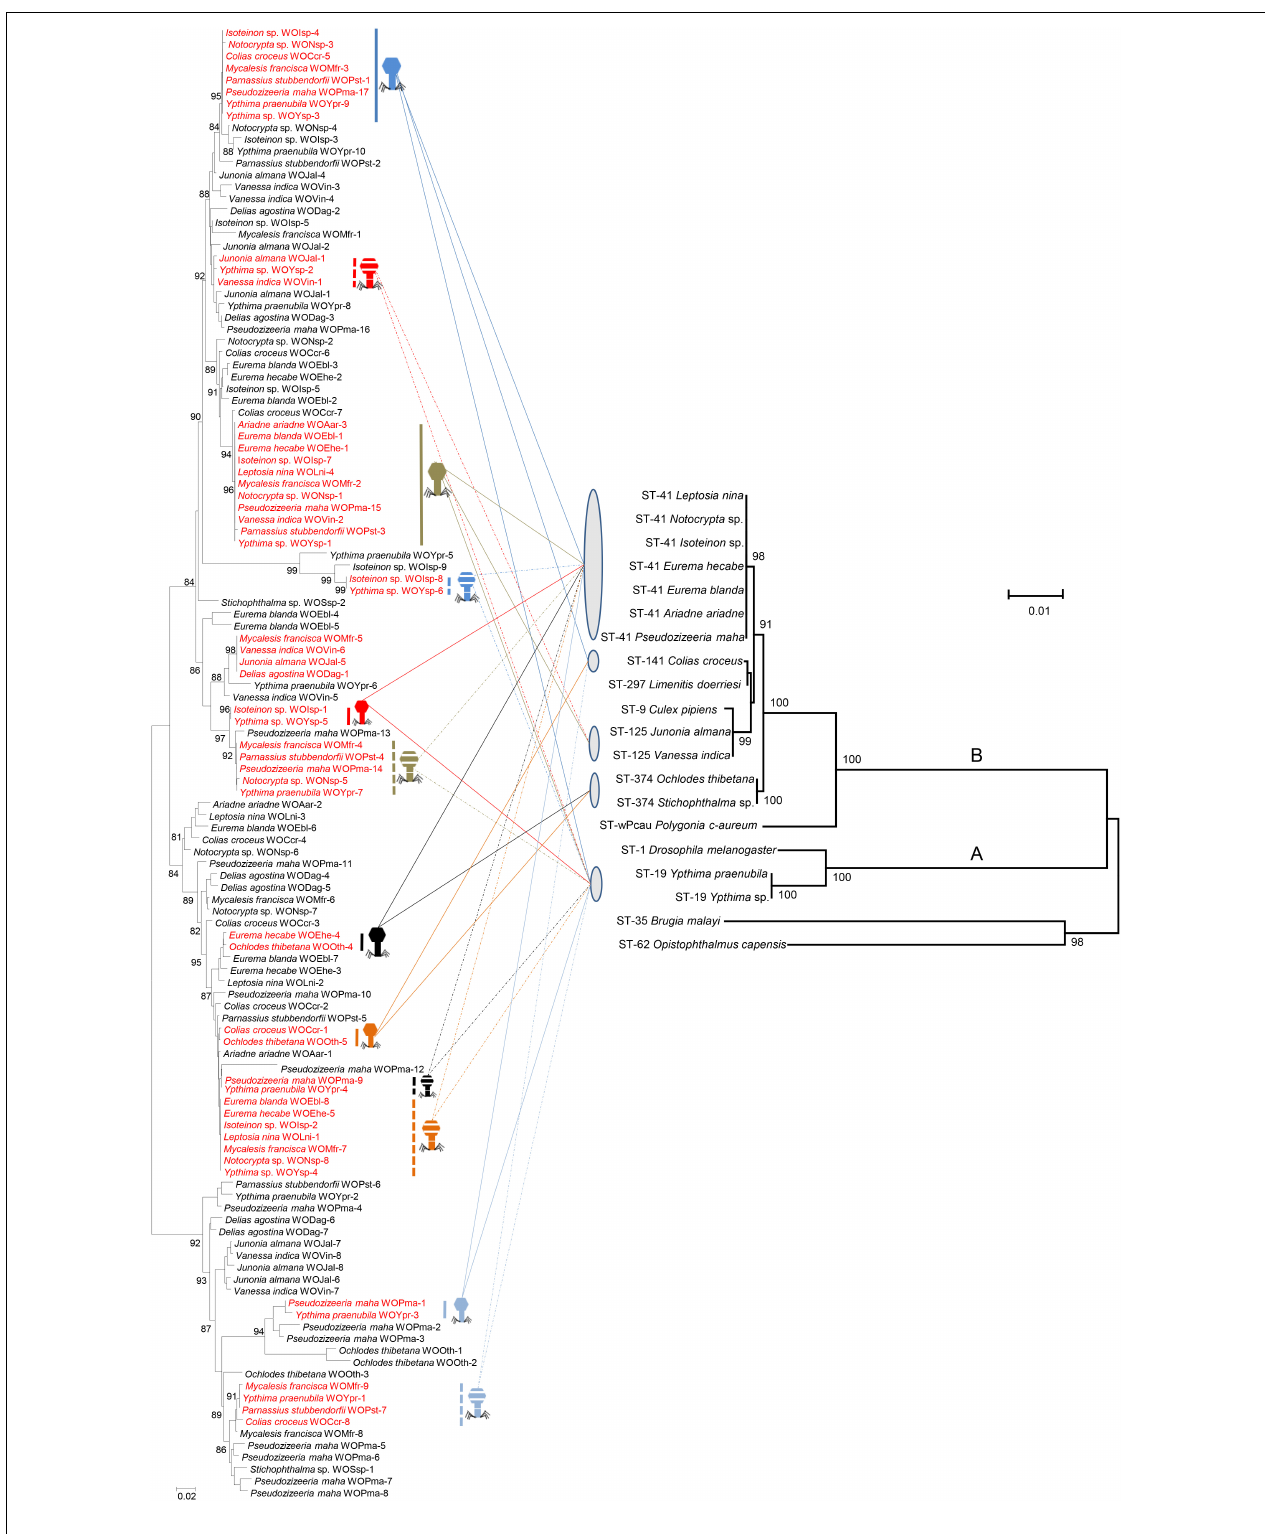
FIGURE 2 | Comparison among phylogenies of phage WO based on orf7 nucleotide sequences (left) and Wolbachia based on concatenated sequences of multi-locus sequence type (MLST) genes (right). Numbers above branches are bootstrap values computed from 1,000 replications. Red font indicates identical orf7 sequences or those with similarity of orf7 sequences greater than 98.5% among their respective accomplices. These accomplices are shown with icons of different colors and shapes. The capital letters on the right indicate the Wolbachia supergroups.